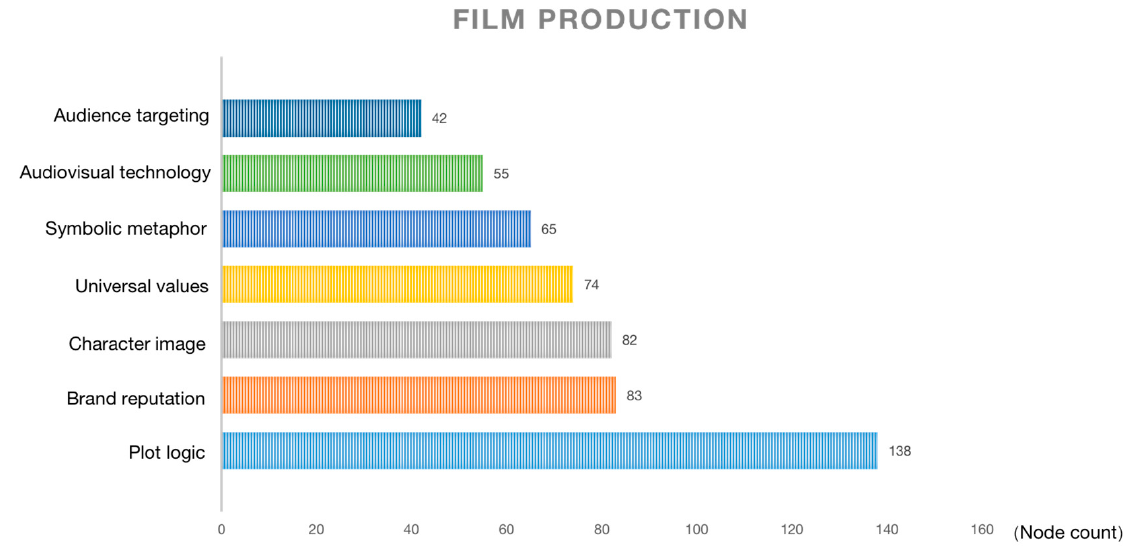
Figure 2. Film production.